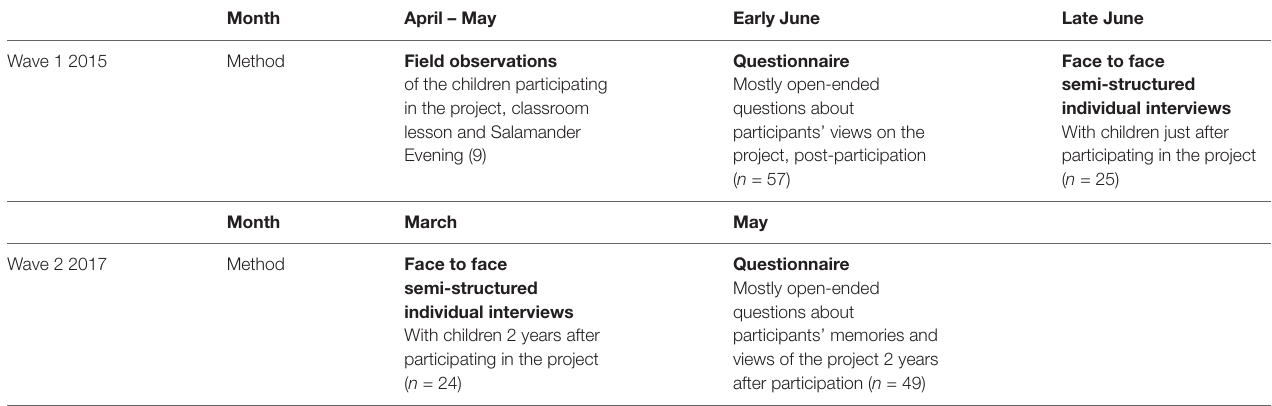
TABLE 1 | Temporal phases of the empirical field